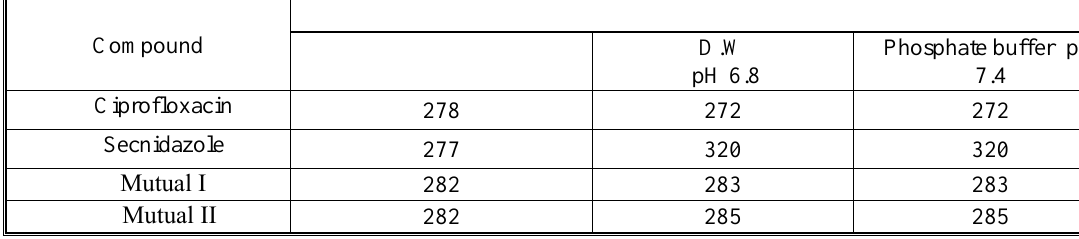
Table 2. The λ Max values of starting and synthesized compounds.